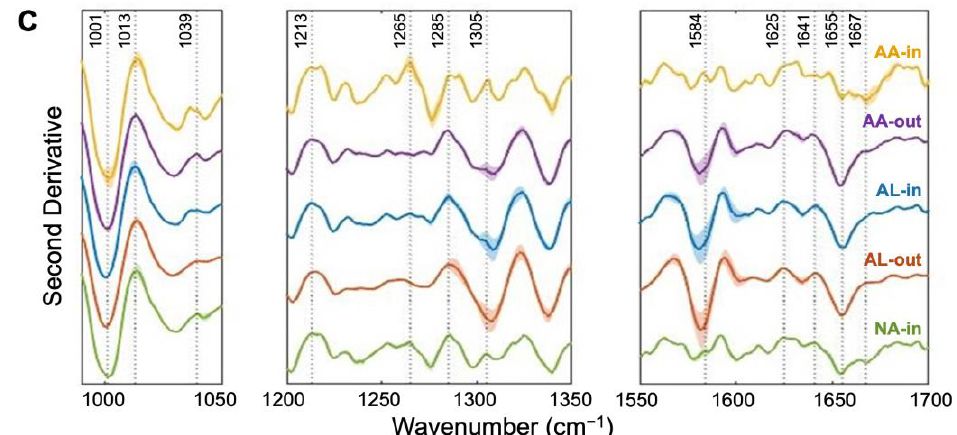
Figure 4. ( A ) Microscopic image of frozen kidney tissue identified with the glomerulus. Scale bar = 100 µ m. ( B ) Averaged and normalized Raman spectra collected within and without glomeruli of AA, AL, and NA tissues with 1 standard deviation shaded. ( C ) Second derivative analysis of phenylalanine (1000–1500 cm − 1 ), amide III (1200–1350 cm − 1 ), and amide II-I (1550–1700 cm − 1 ). Each spectrum in ( B , C ) is color-coded based on the type and deposition site and plotted in order, from top to bottom: AA-within glomeruli, AA-without glomeruli, AL-within glomeruli, AL-without glomeruli, and NA.